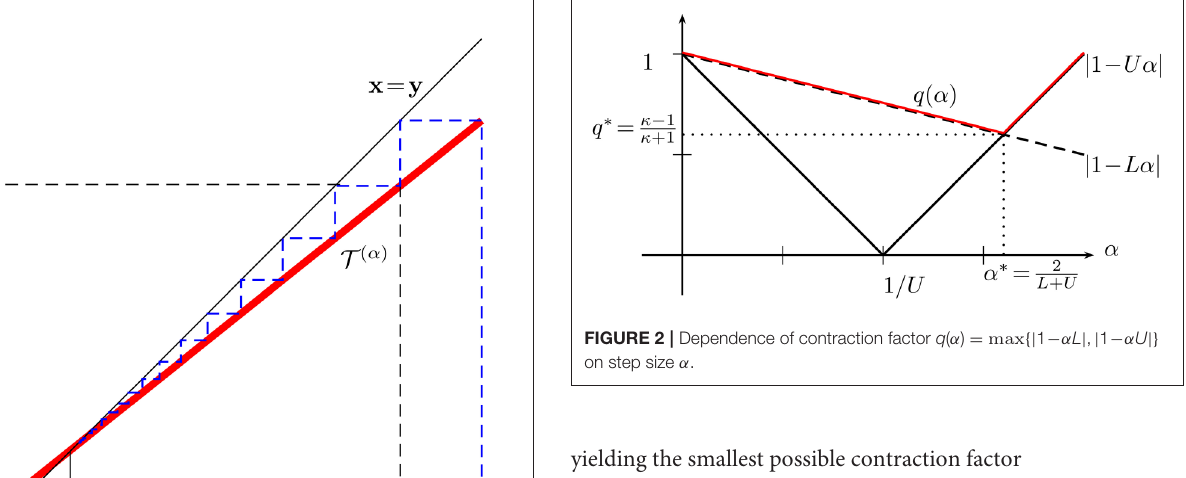
FIGURE 2 | Dependence of contraction factor q ( α ) on step size α